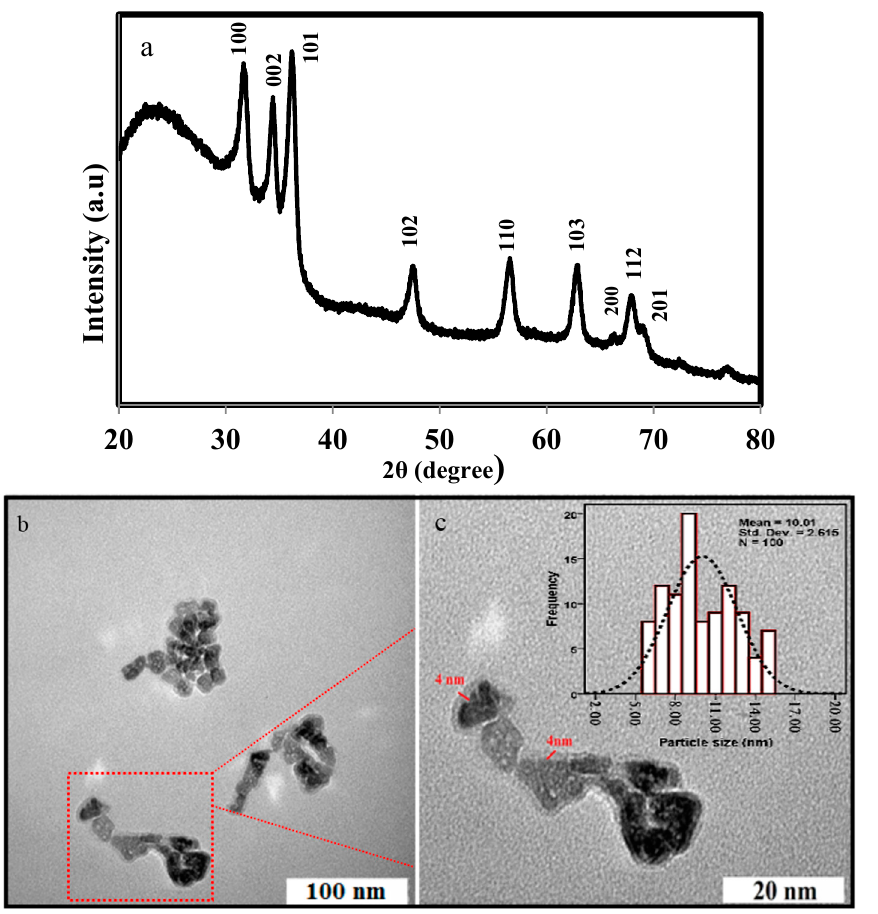
Figure 2. ( a ) The XRD pattern; ( b , c ) TEM images and (inset) particle size distribution histogram of ZnO-NPs.